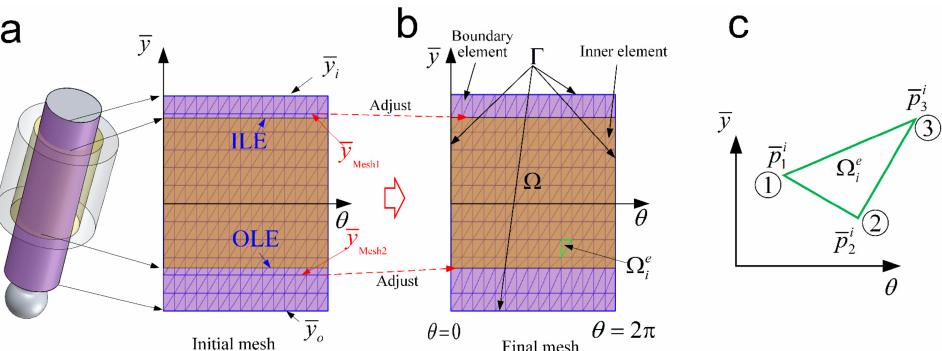
Figure 2. The meshing diagram: ( a ) The initial mesh for the whole domain, ( b ) the final mesh after the fine adjustment, and ( c ) the diagram of an